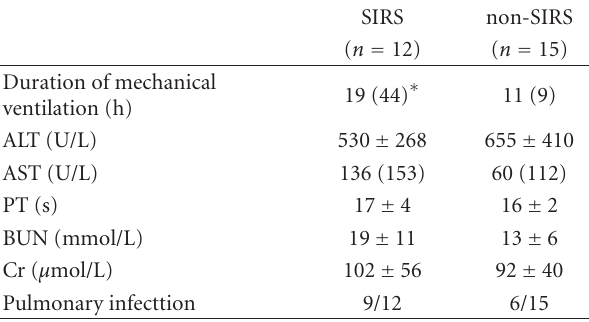
Table 4: Postoperative clinical characteristics in SIRS versus non- SIRS.